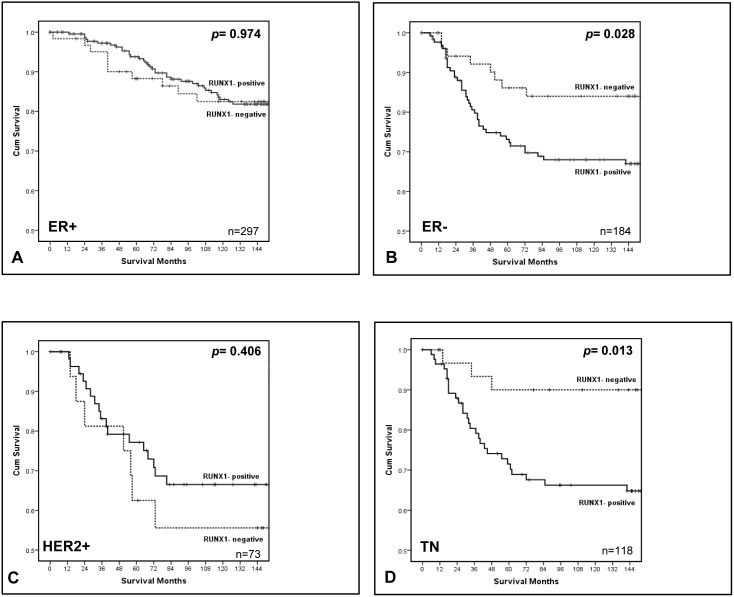
RUNX1 expression and cancer-specific survival in different subtypes of breast cancer.The association between the absence and the presence of RUNX1 and cancer-specific survival in patients with (A) ER-positive, (B) ER-negative, (C) HER2-positive and (D) triple negative (TN) primary operable breast cancer. Survival is plotted for patients with cancers positive for RUNX1 (solid line), or those with no RUNX1 expression (dotted line). ER+ cohort (n = 297), p = 0.974; ER– (n = 184), p = 0.028; HER2+ cohort (n = 73), p = 0.406; TN cohort (n = 118), p = 0.013. P-values calculated using Log Rank (Mantel-Cox) test.